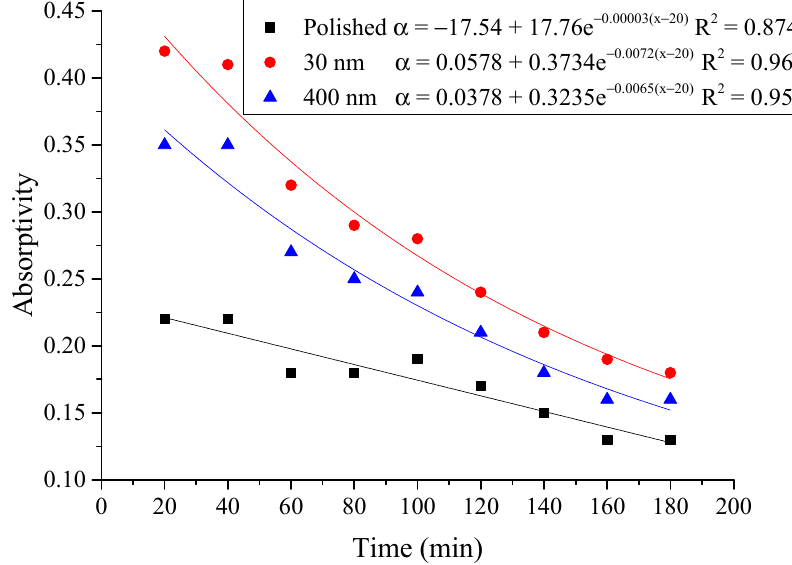
Figure 16. Variation of the average absorptivity for the testing rigs operated under the simulated radiation of 300 W/m 2 .